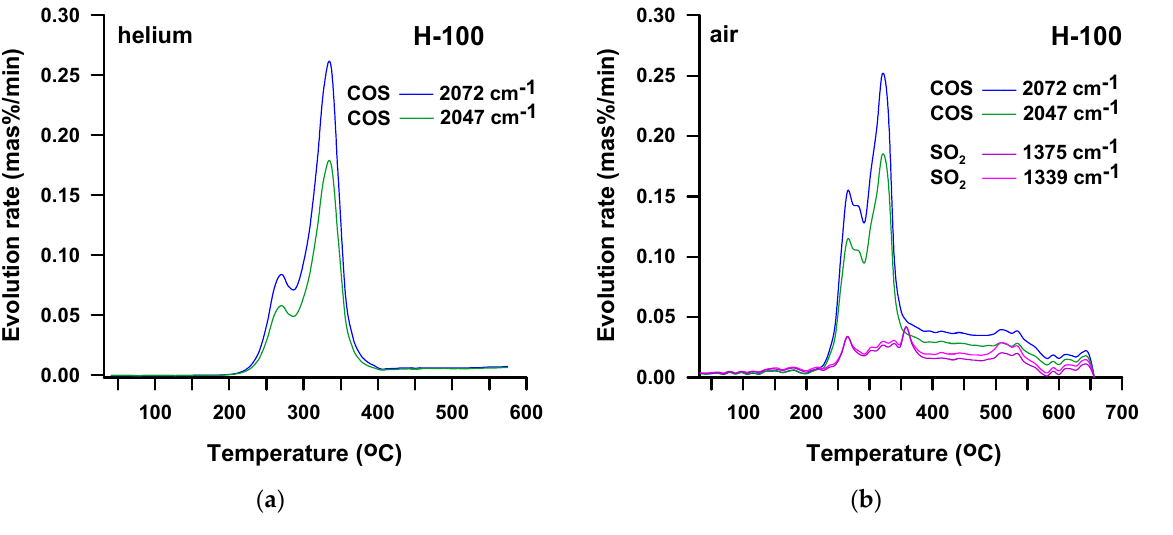
Figure 5. ( a ) Carbonyl sulfide release for H-100 sample during TG-FTIR analysis in helium and ( b ) carbonyl sulfide and sulfur dioxide release for H-100 sample during TG-FTIR analysis in air. The FTIR spectra obtained from the analysis of the H-100 sample in the air atmos-